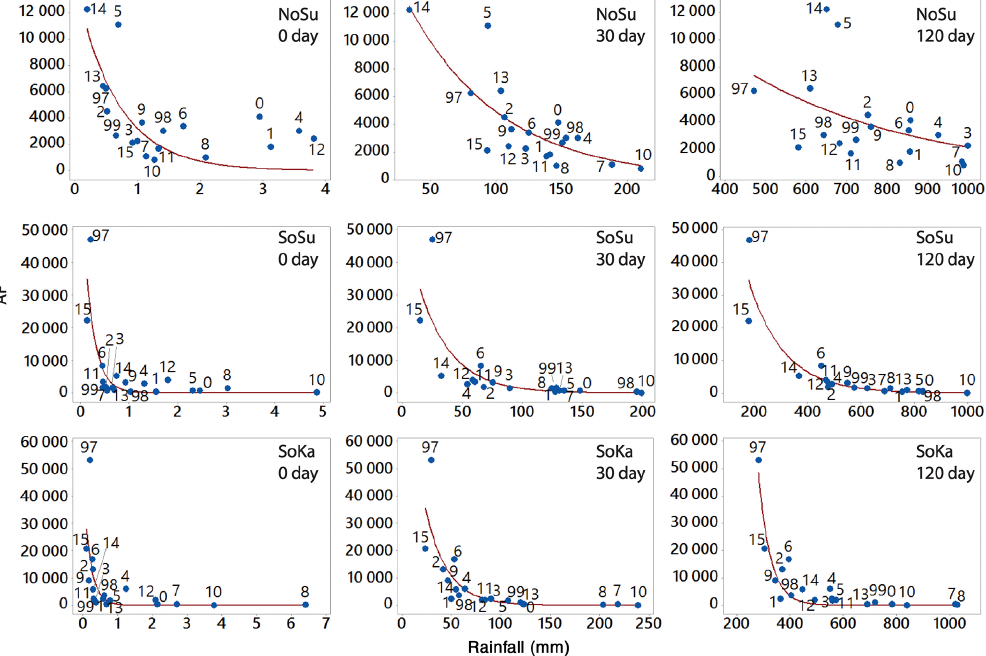
Figure 8. Mean rainfall accumulation before fire (with exponential trend line) for each climatic region with a 0 (left column), 30 (middle column) and 120 days (right column) buildup. The numbers in the graph denote the year (97 is 1997, 0 is 2000, through to 15 is 2015).